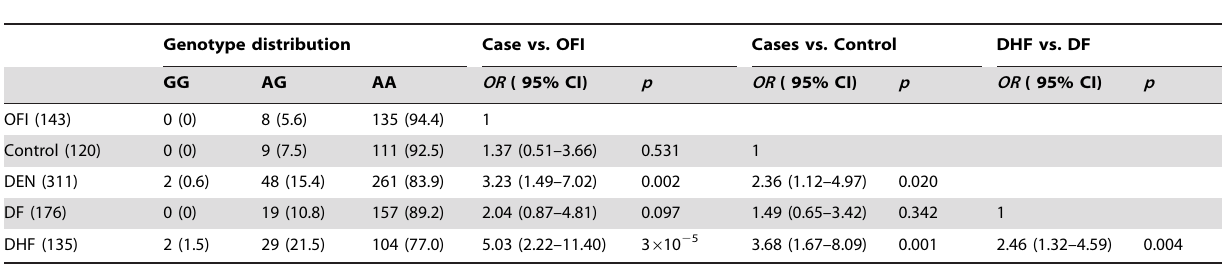
Table 2. Distribution of CD209 2 336 A/G (rs4804803) genotype in patients with dengue infection (DEN) and other non-dengue febrile illnesses (OFI) or population